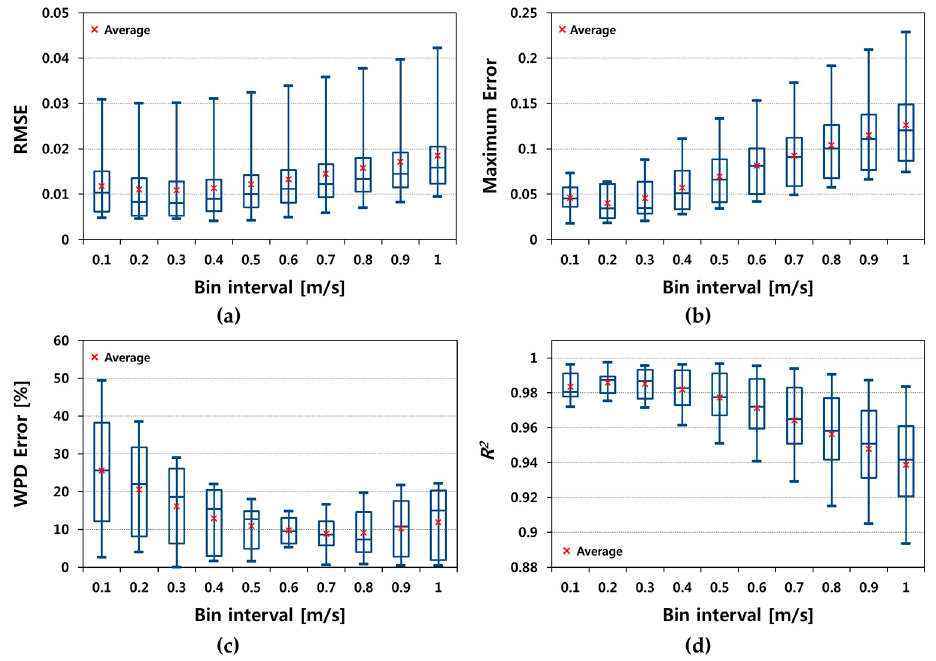
Figure 3. The results of the accuracy tests according to bin interval (graphical method). ( a ) RMSE; ( b ) Maximum error; ( c ) WPD error; ( d ) R 2 .